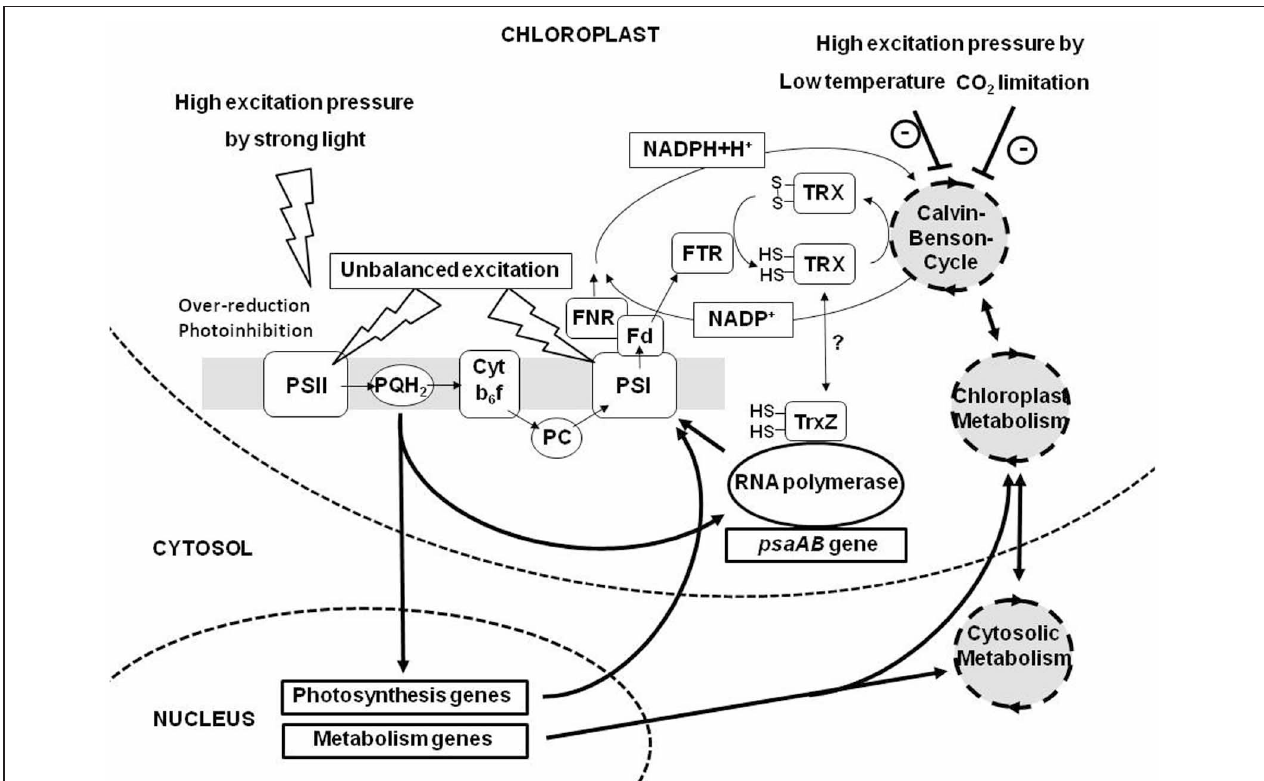
Electron transport and transfer of reducing power are indicated by thin black arrows. Redox signaling, metabolic interactions, and feedback regulation from gene expression are indicated by thick black arrows. Fd, ferredoxin; FNR, ferredoxin-NADP-oxidoreductase; FTR, ferredoxin-thioredoxin-oxidoreductase; PC, plastocyanin; psaAB, plastid genes for the apoproteins PsaA and PsaB of PSI (the main triggers of photosystem stoichiometry adjustment). For further details see text. How TrxZ is reduced and how it regulates the plastid RNA polymerase is unknown to